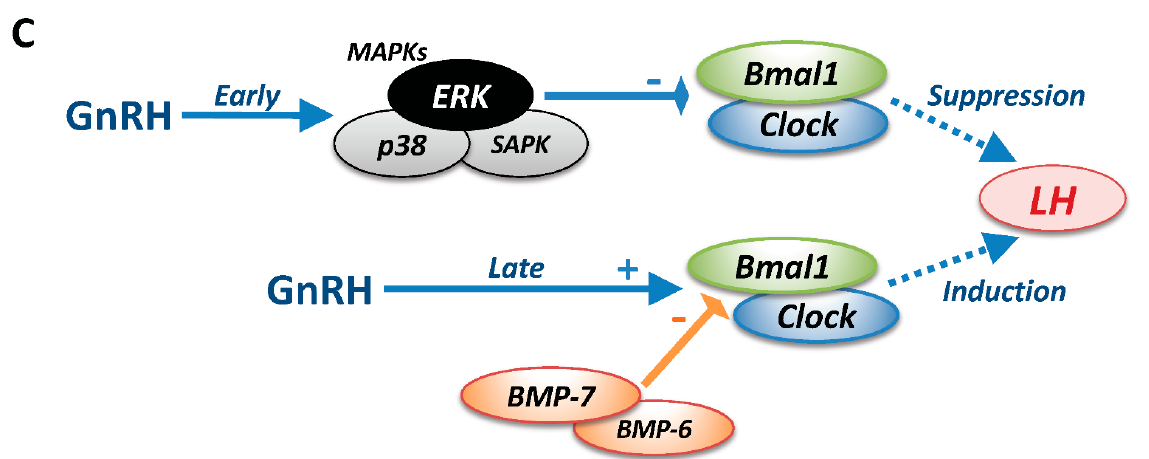
Figure 3. Effects of Clock gene suppression and BMPs on LH and Clock genes expression induced by GnRH in gonadotrope cells. ( A ) L β T2 cells (1 × 10 5 cells/mL) were transiently transfected with Bmal1- or Clock-specific RNA or control siRNA and then incubated with or without GnRH (10 nM) for 24 h. Total RNAs were extracted, and the mRNA levels of Bmal1, Clock and LH β were standardized by RPL19 levels and expressed as fold changes. ( B ) Cells (1 × 10 5 cells/mL) were treated with BMP-6 and -7 (30 ng/mL) in serum-free DMEM in the presence or absence of GnRH (10 nM). After 24 h culture, total RNAs were extracted, and the mRNA levels of LH β , Bmal1, and Clock mRNA were standardized by RPL19 levels and expressed as fold changes. Results are shown as means ± SEM. The results were analyzed by the unpaired t -test or ANOVA. The values with different superscript letters are significantly different at p < 0.05, and * p < 0.05 between the indicated groups and vs. control groups. ( C ) Biphasic effects of Clock genes and BMPs on GnRH-induced LH expression by gonadotrope cells. GnRH stimulation exhibits inhibitory effects on Bmal1/Clock expression at the early phase via the ERK pathway, leading to suppression of LH expression. At the late phase of GnRH stimulation, GnRH increases LH mRNA expression via upregulation of Bmal1/Clock expression, with BMP-6 and -7 suppressing the expression of Bmal1 induced by GnRH. Thus, phase-dependent roles of MAPK and BMPs in Clock gene-dependent LH expression induced by GnRH were shown in gonadotrope